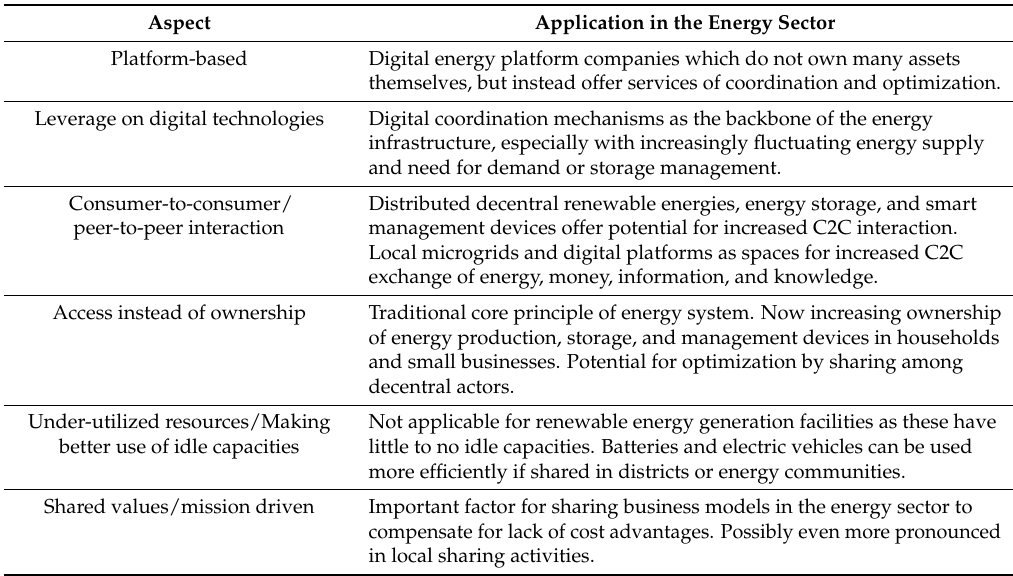
Table 4. Defining characteristics of the sharing economy and their applicability in the energy sector.